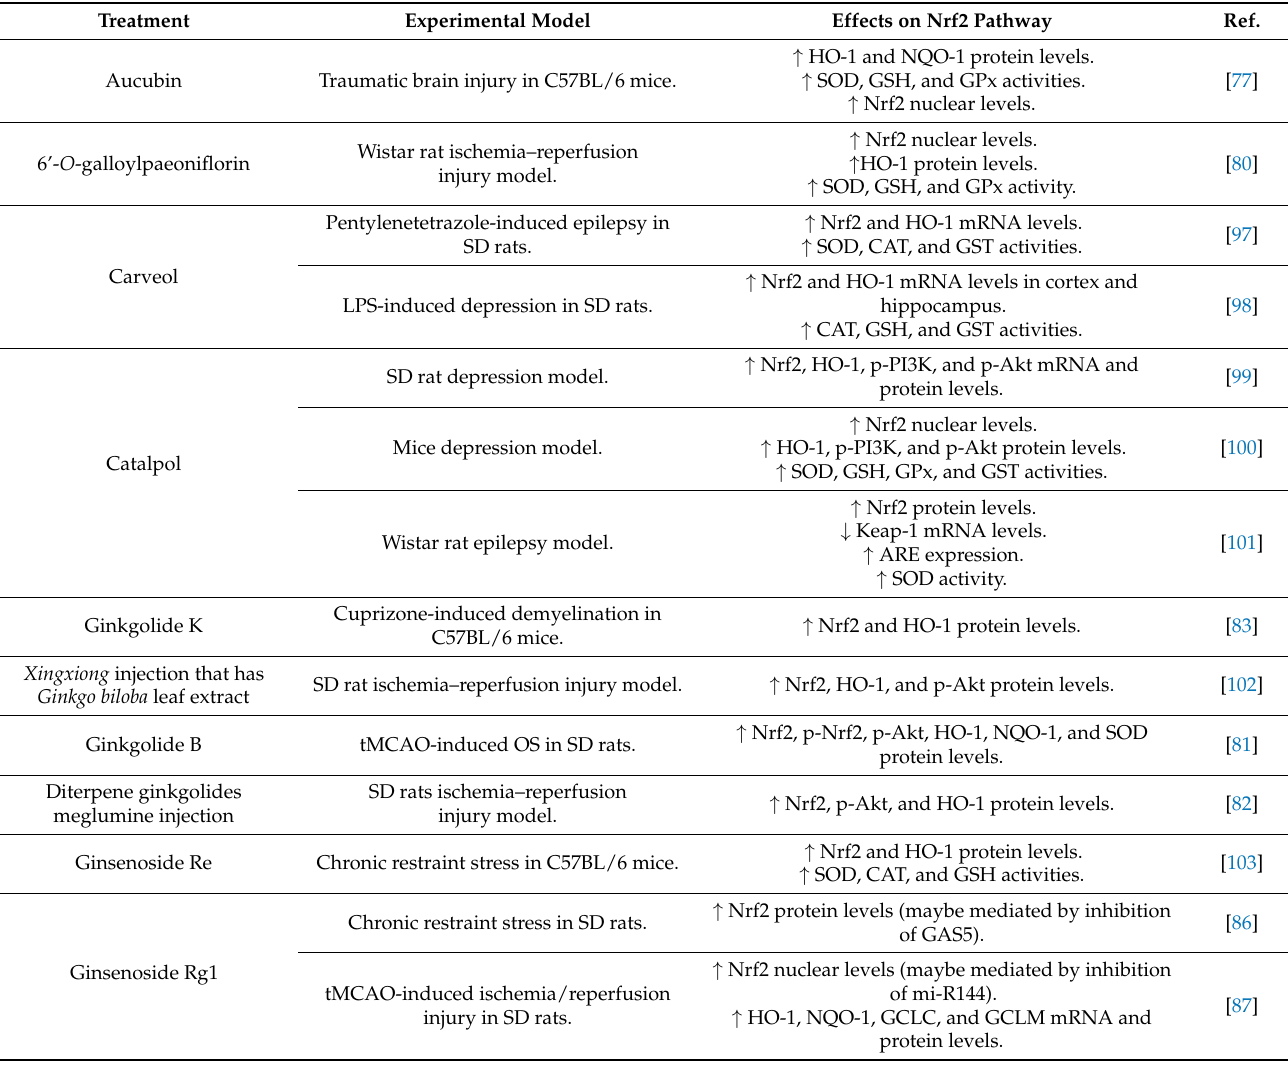
Table 4. Modulation of terpenoids on Nrf2 pathway in in vivo models. The increase in protein or RNAm levels are represented with ( ↑ ) and decrease is represented with ( ↓